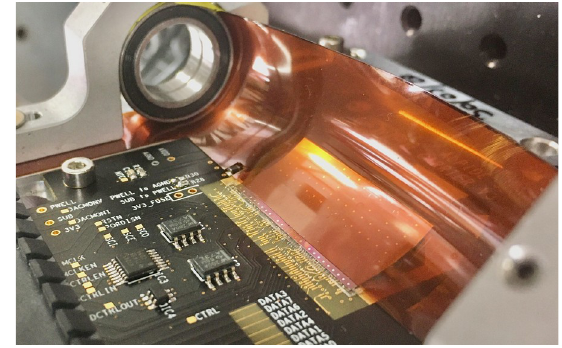
Fig. 3. ALPIDE sensor bent along the short edge to a radius of 18